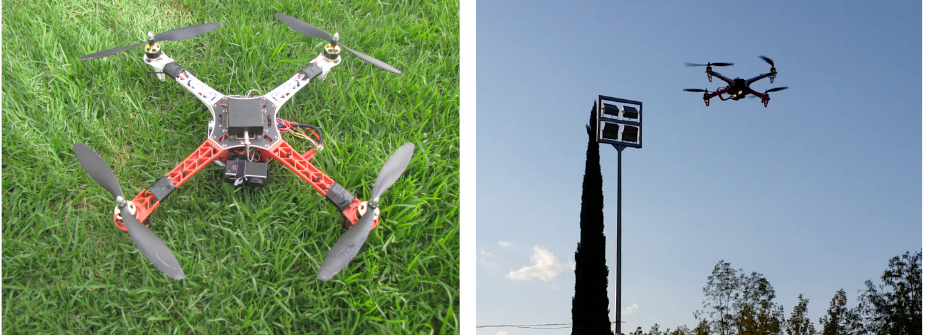
Figure 4. The quadrotor mini-helicopter in